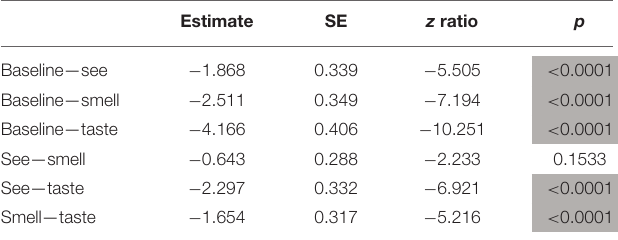
TABLE 5A | Character’s opinion responses: pairwise comparisons for Experiment 3.